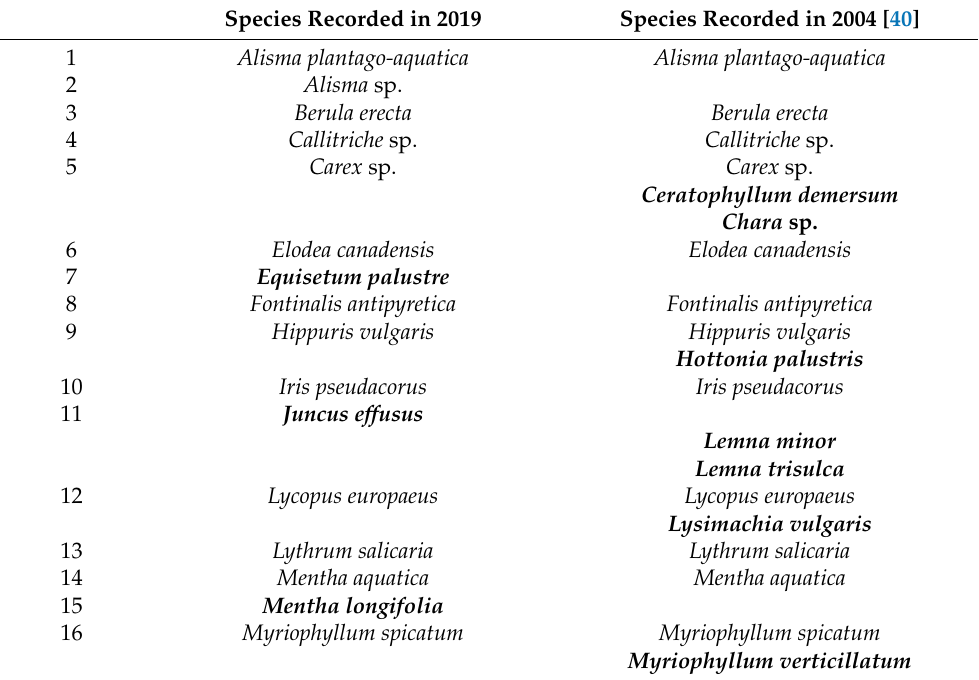
Table 1. List of recorded macrophyte taxa in the Ljubljanica River in years 2004 (according to [40]) and in 2019. Taxa not common to both years are marked in